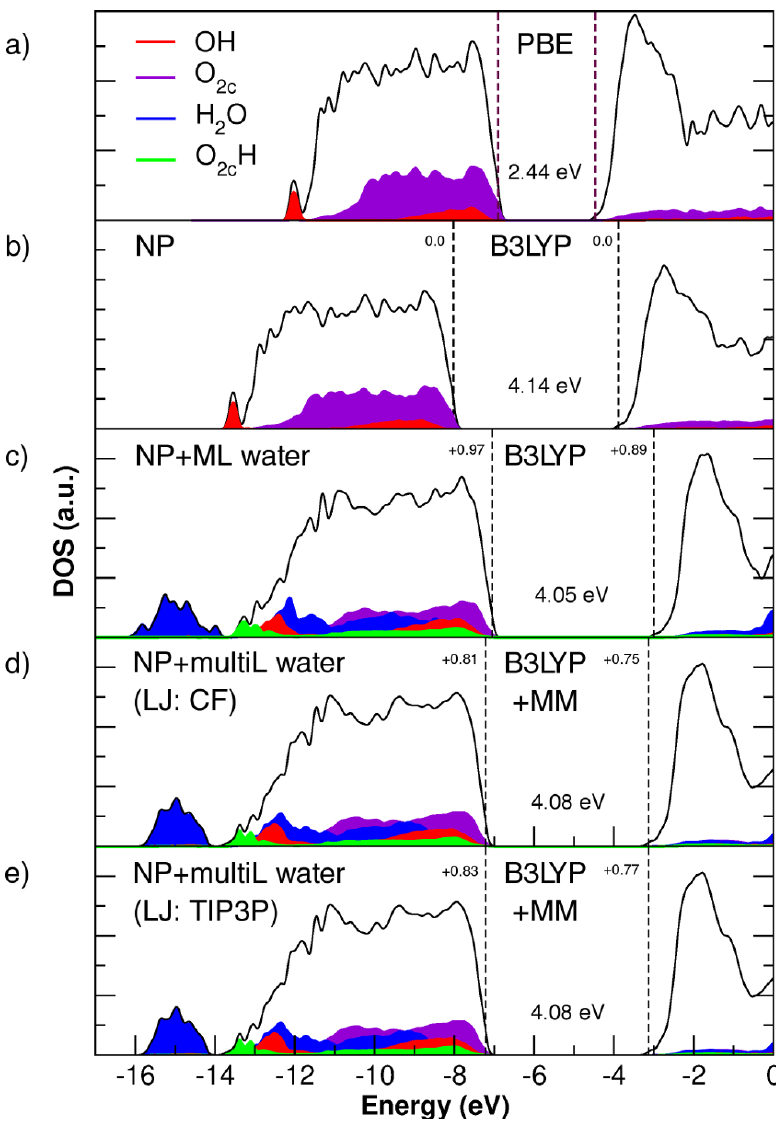
Figure 6. Total (DOS) and projected density (PDOS) of states on di ff erent oxygen species of: ( a ) the NP in vacuum calculated with the PBE functional; ( b ) the NP in vacuum calculated with the B3LYP functional; ( c ) the NP with a QM water monolayer; ( d ) with a QM / MM water multilayer and the CF LJ parameters; and ( e ) with a QM / MM water multilayer and the TIP3P LJ parameters. In each panel, the band gap and the energy shift of the valence and conduction band edges with respect to the vacuum NP model in a vacuum are given in eV. The zero energy is set to the vacuum level. Panels ( b , c ) are from previous work by some of the authors